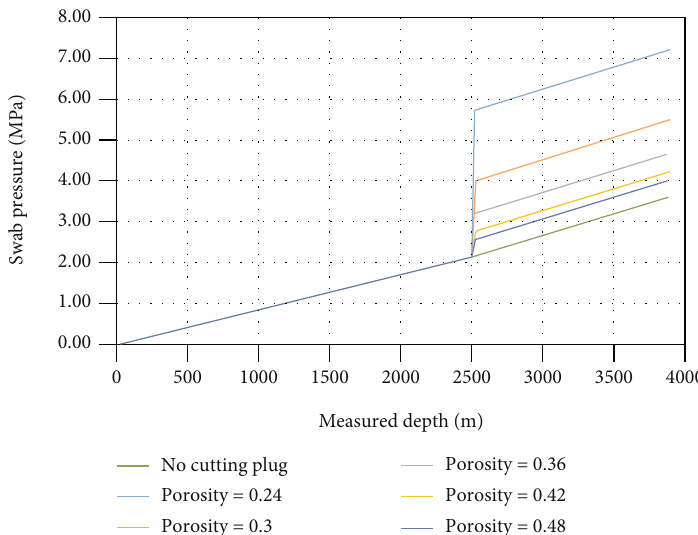
Figure 7: The e ff ect of cutting plug porosity on the swab pressures in a closed pipe condition.